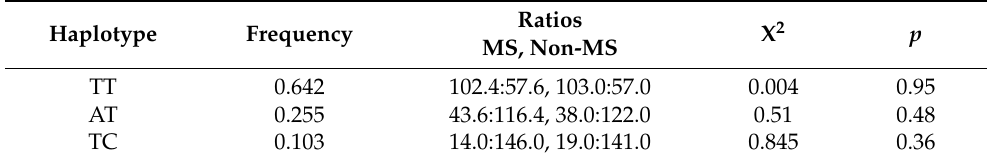
Table 5. Association of haplotypes with metabolic